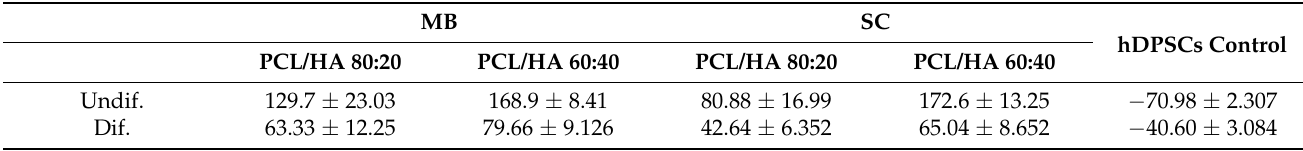
Table 7. ARS semi-quantification in mM between groups. The results of % mineral deposition enhancement are presented in mean ± SE, normalized to the PCL MB as 0%. MB